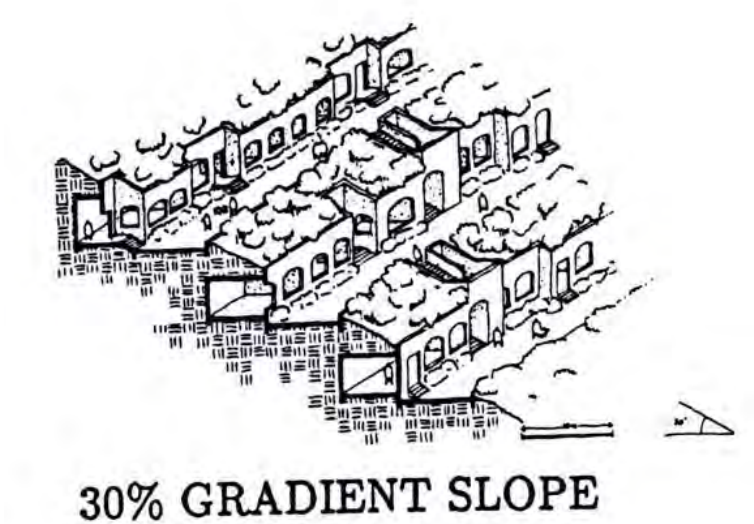
Figure 8. The preferred slope gradient for new earth-shelteredconstruction is 30% degree, (Golany and Ojima1996).